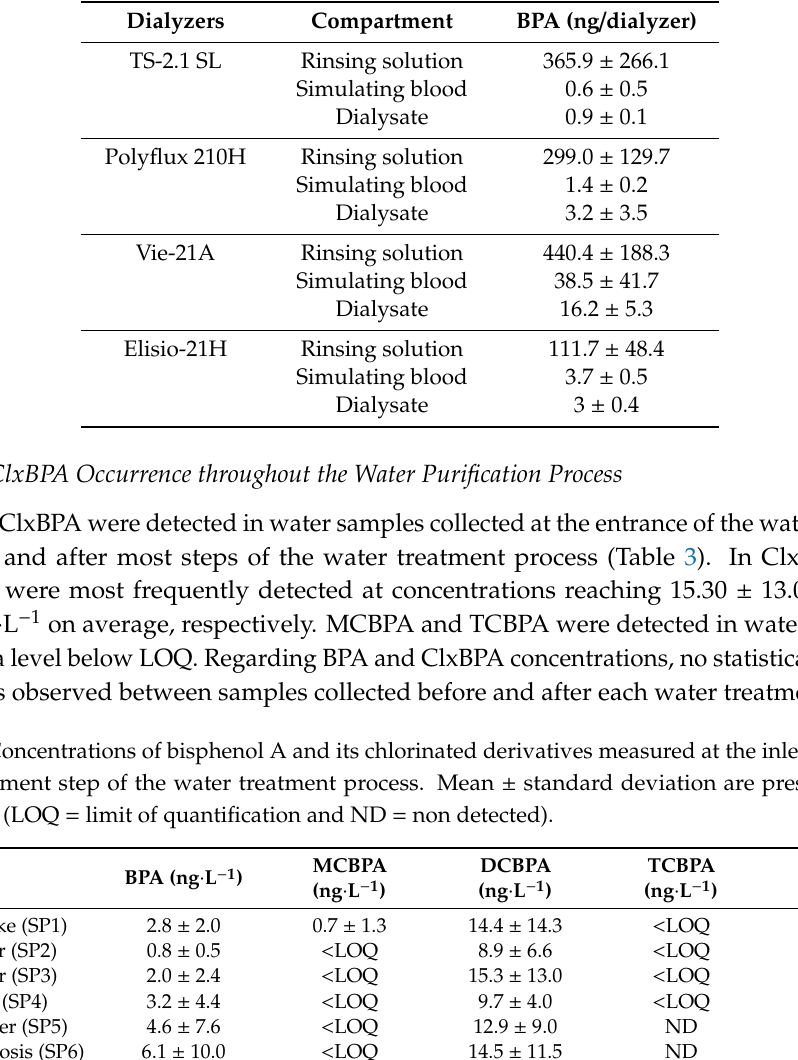
Table 2. Amount of bisphenol A (BPA) released from the dialyzers used for online hemodiafiltration. Mean ± standard deviation are presented.